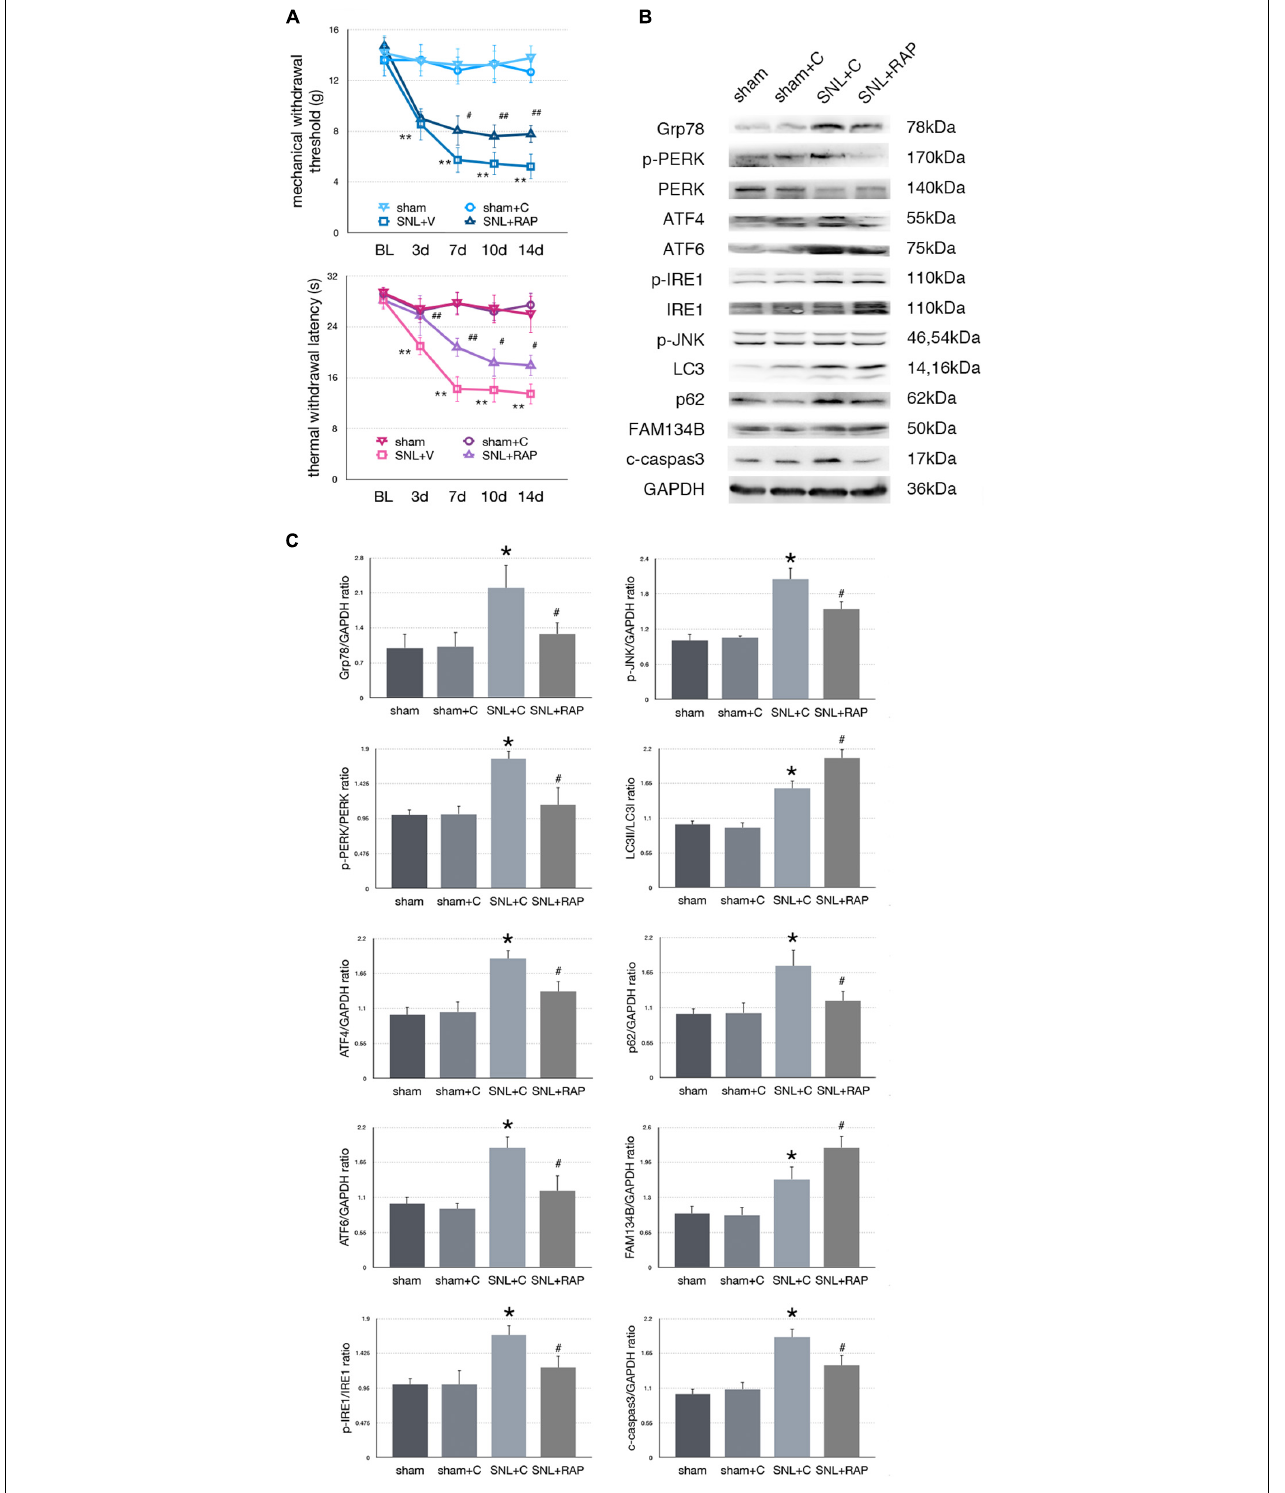
FIGURE 5 | Effect of rapamycin on pain-related behavior tests and protein expression. (A) Application of rapamycin induces pain relief effect via TWL and MWT tests. (B) Rapamycin counteracts SNL-induced ER stress and increases ER-phagy in spinal cord. (C) Quantifications of Western blot in sham, sham + C, SNL + C, and SNL + RAP groups. Protein expressions in spinal cord are shown. Data are presented as mean ± SD, n = 6 rats per group. sham vs. sham + C have no significant difference; * p < 0.05 SNL + C group vs. sham + C group; # p < 0.05 SNL + 4-PBA vs. SNL + C group. In behavior tests, ** p < 0.01, ## p < 0.01.